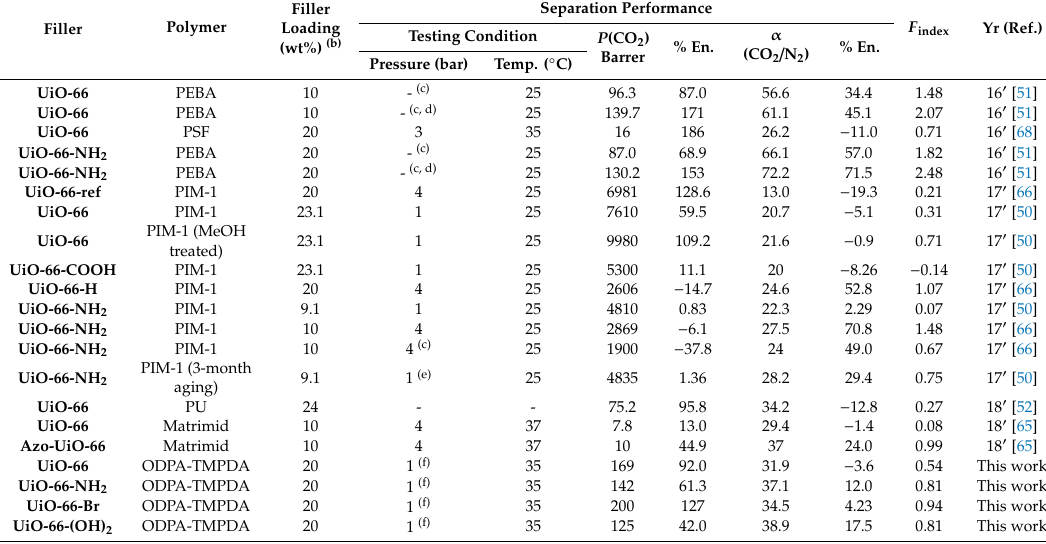
Table 4. Summary of gas permeation results of the mixed-matrix membranes that utilize UiO-66 and its derivatives (a)